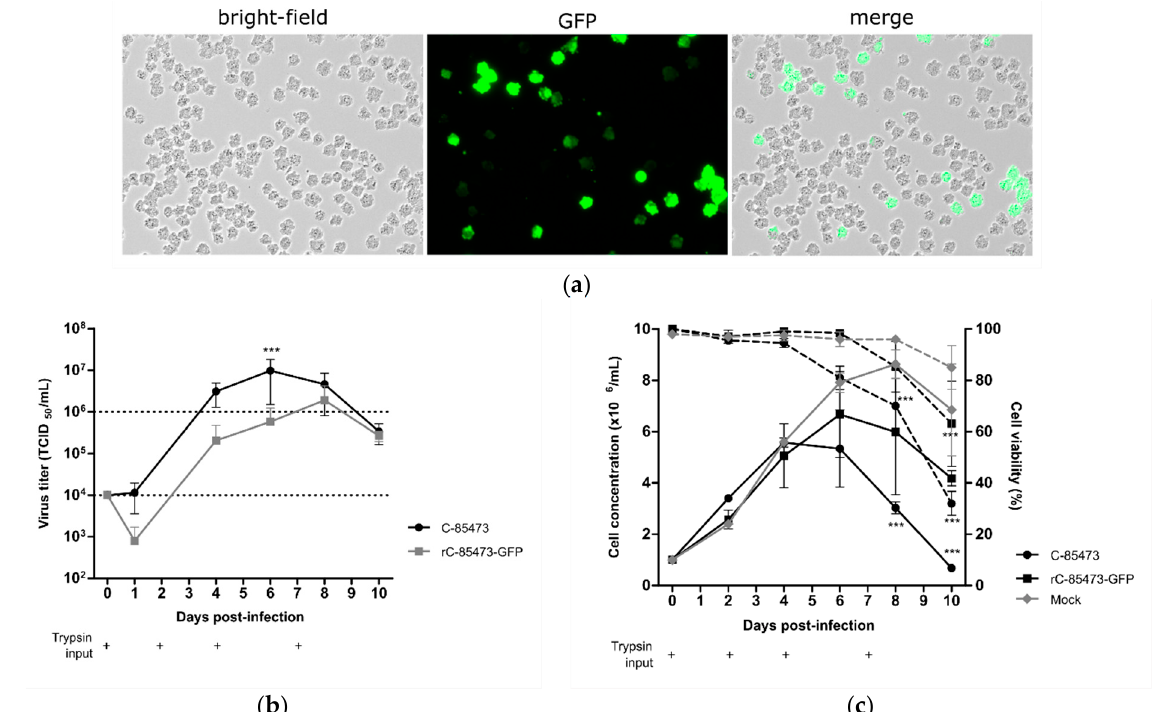
Figure 1. Viral kinetics of wild-type C-85473 HMPV and recombinant rC-85473-GFP HPMV in the DuckCelt ® -T17 cell line. Cells seeded at 1 × 10 6 cell/mL in 10 mL working volume and infected at an MOI of 0.01. Trypsin added at 0.5 µg/mL on Day (D) 0, D2, D4, and D7 (+). ( a ) Picture of T17 cells infected with rC-85473-GFP at 7 days post-infection (dpi). Each picture was taken in bright field and fluorescent microscopy (20× magnification, scale bars represent 150 µm); ( b ) viral titers measured from culture medium as 50% tissue culture infectious doses (TCID50)/mL in LLC-MK2 cells; ( c ) cell growth (solid line) and viability percentage (dotted line) measured with the Countess™ II FL Automated Cell Counter. Results shown as means ± SD and represent duplicates in two independent experiments. *** p < 0.001 when comparing the infected conditions to ( b ) each other or ( c ) the mock condition using two-way repeated measures ANOVA.